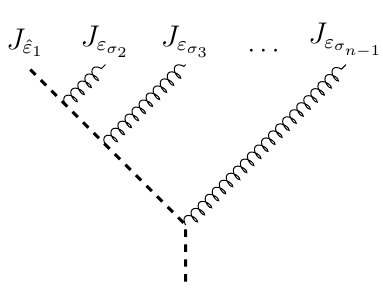
Figure 1 . Fusion product in the canonical ordering. The algebra simpli(cid:12)es by demanding that ^ " 1 corresponds to a scalar, since the internal currents must carry this